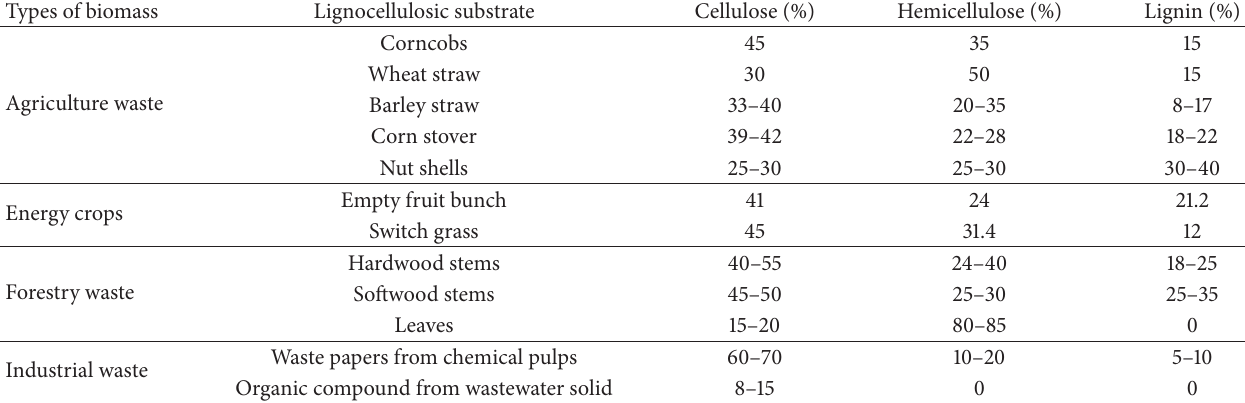
Table 1: Chemical composition of common agricultural residues and